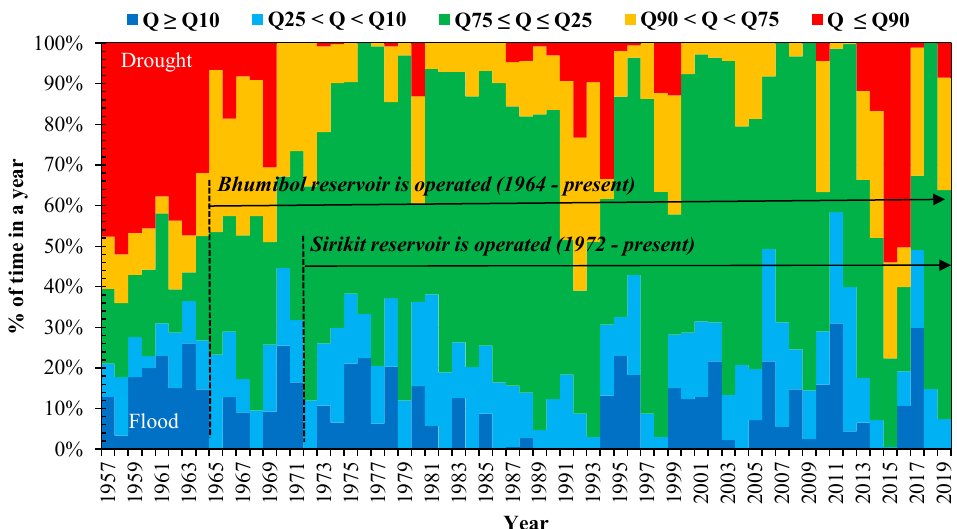
Figure 2. Flow-duration analysis at the C.2 gauging station.